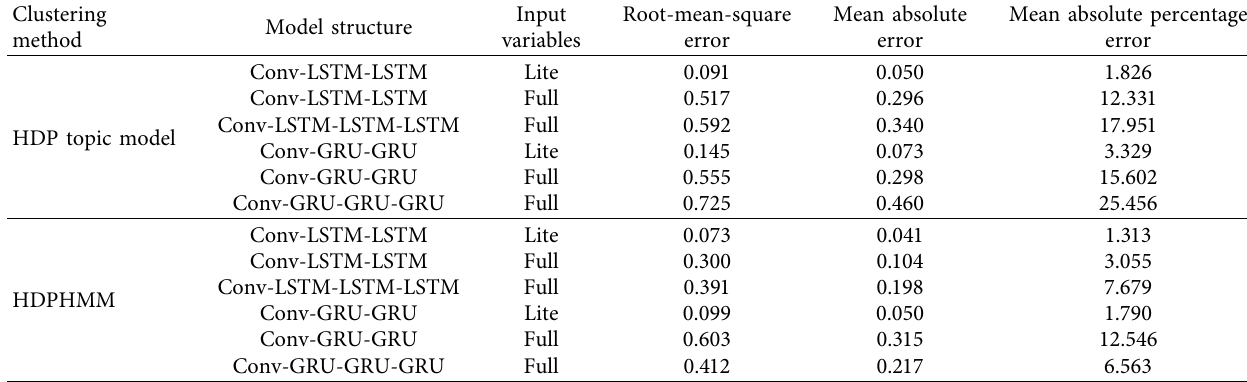
Table 4: Comparisons on clustering method, model structure, and input version.